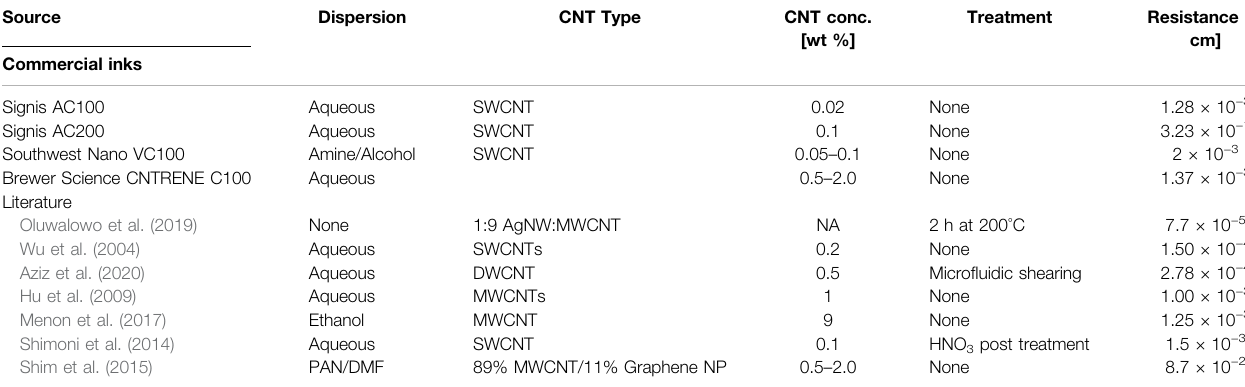
TABLE 1 | Resistivity comparison of CNT based conductive inks on the market and in the literature.